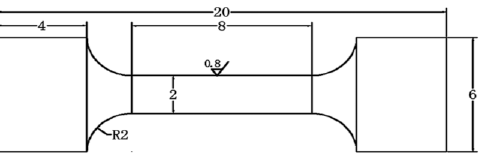
Figure 1. Dimensions and schematic of the tensile specimens (thickness: 3